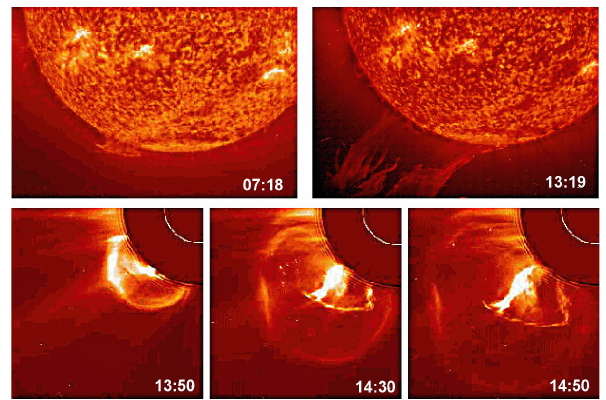
Fig. 1. Polar crown filament eruption on 14 June 1999 visible in SOHO/EIT He II